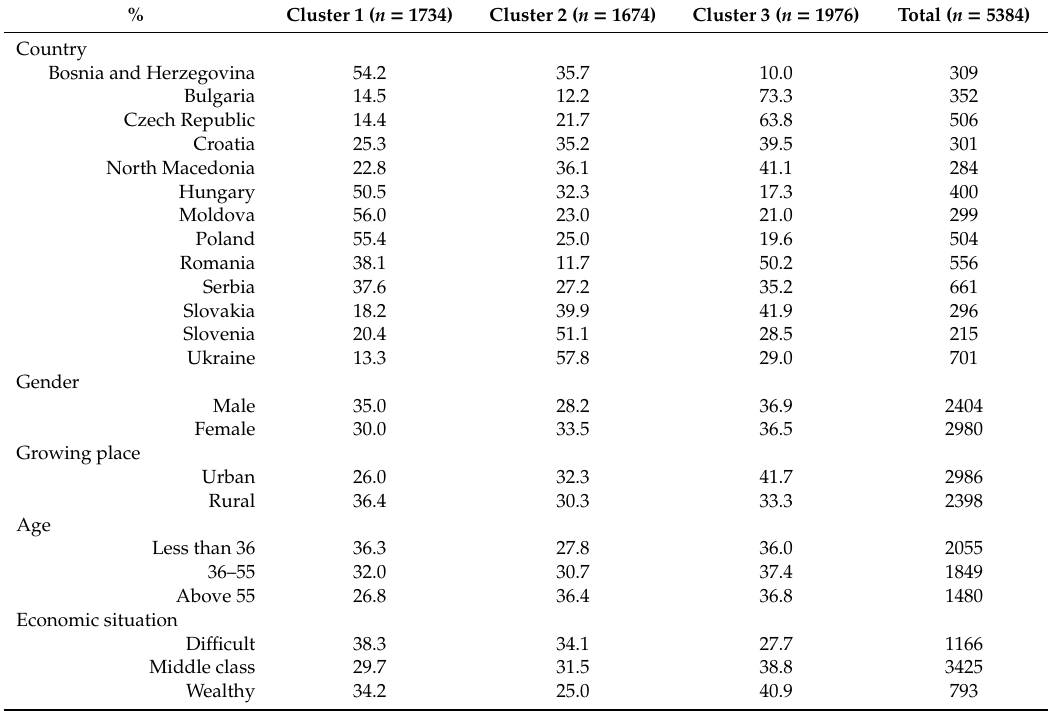
Table 6. Description of the three clusters in terms of